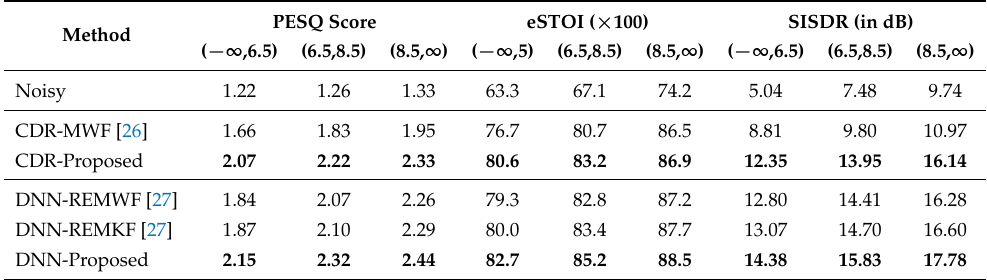
Table 4. The PESQ scores, eSTOIs, and SISDRs for the baselines and the proposed method depending on the SNR.